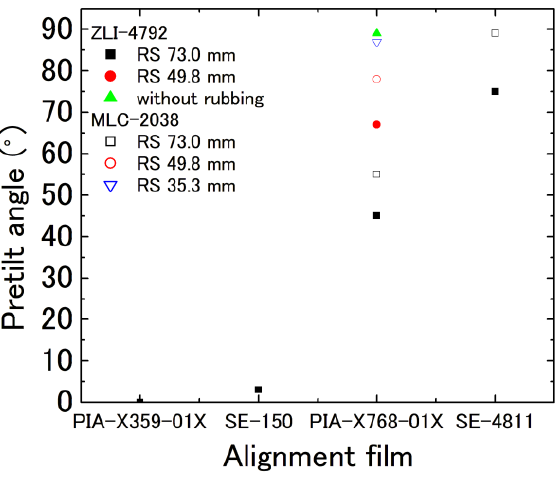
Figure 1. Pretilt angles for ZLI-4792 or MLC-2038 for different PI films as function of